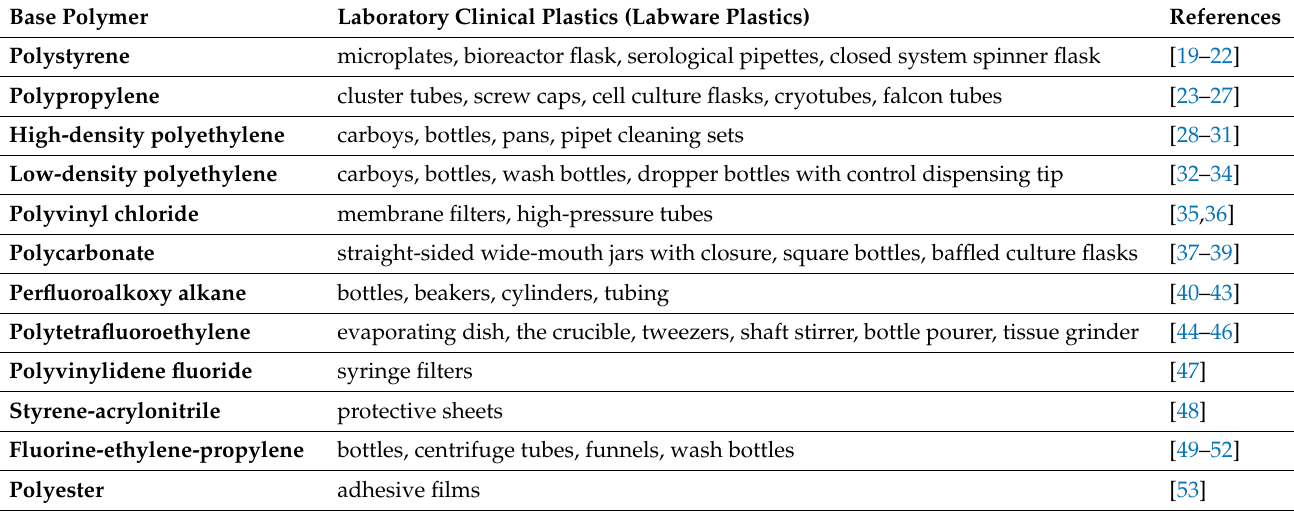
Table 1. Base polymers in laboratory clinical plastics.